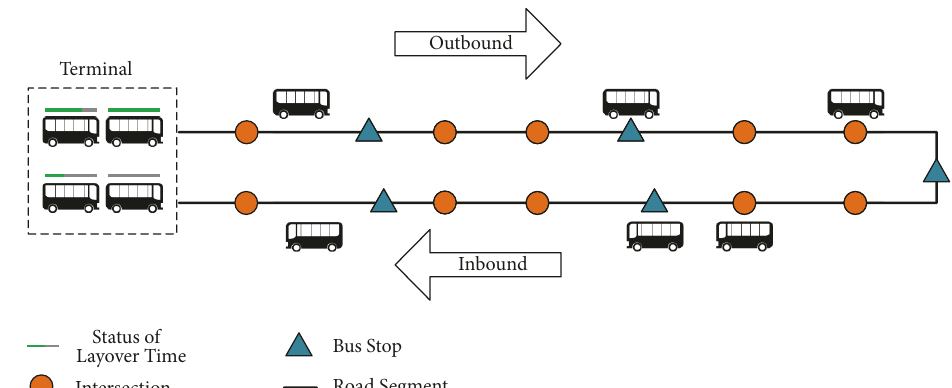
Figure 3: Illustration of the simulation platform.